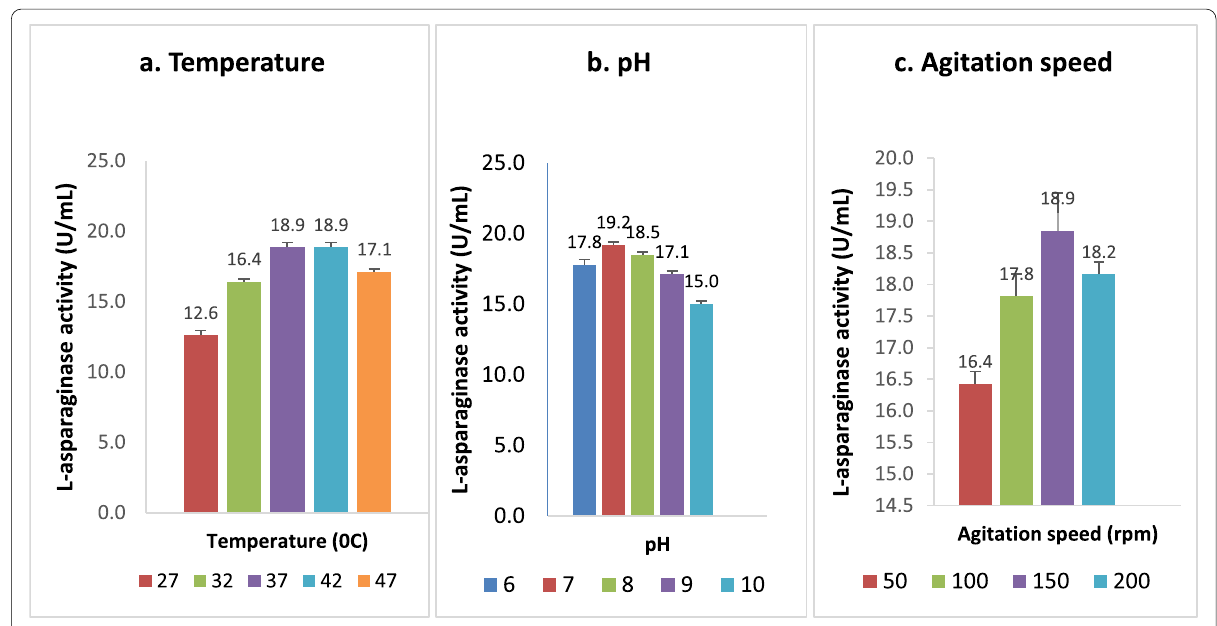
Fig. 1 OFAT optimization of a temperature, b pH, and c agitation speed